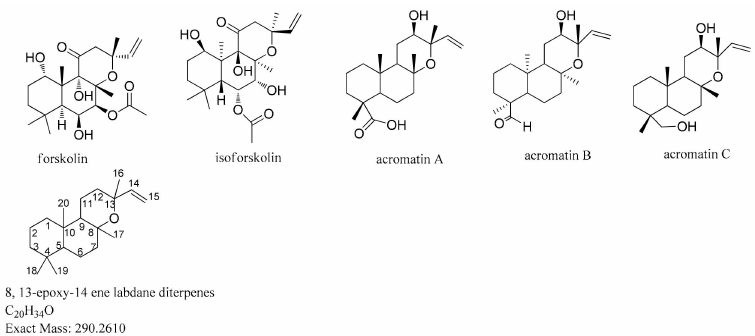
Figure 2. The chemical structure of reference compounds.